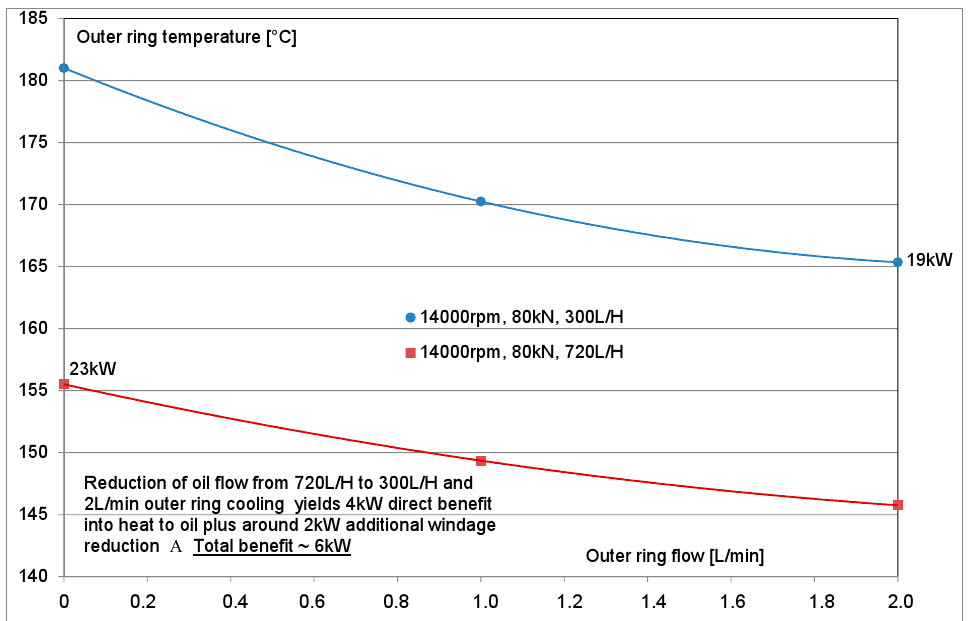
Figure 8. Heat to oil and lubricant flow reduction through the outer ring cooling concept.